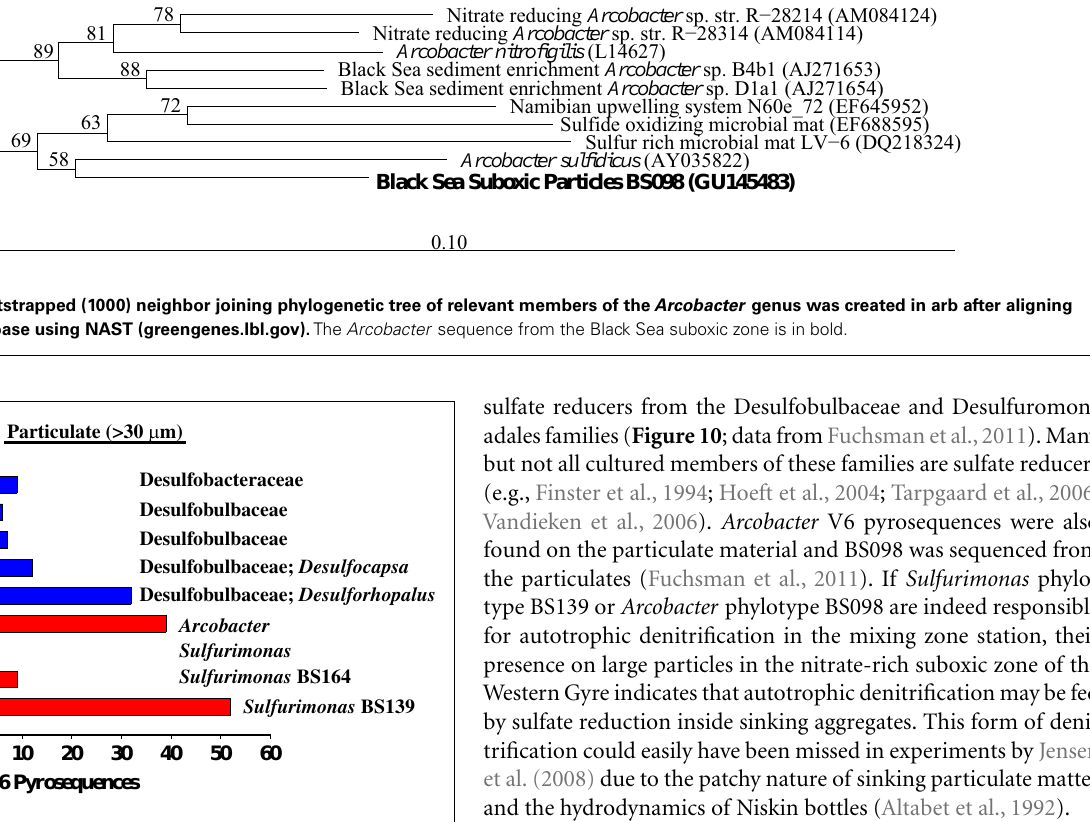
FIGURE 10 | Examples of potential sulfate reducers (blue) or sulfide oxidizers (red) enriched in particulate sample (30 µ m filter) from σ θ = 15.8 in theWestern Gyre in 2005 compared to a bulk sample from the same depth, as determined fromV6 pyrosequences (data from Fuchsman et al., 2011,